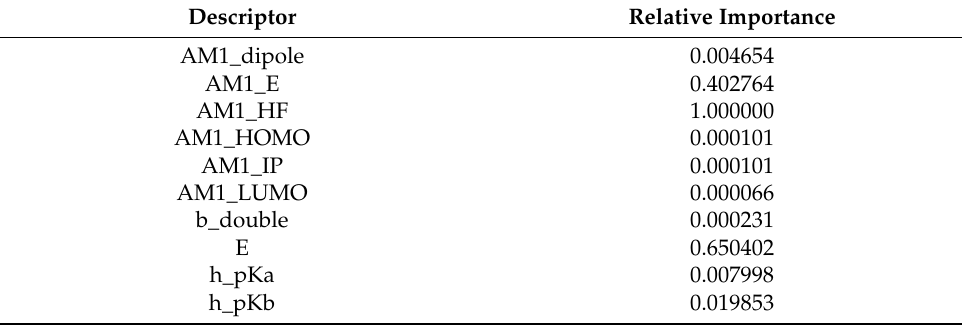
Table 6. Relative Importance of selected